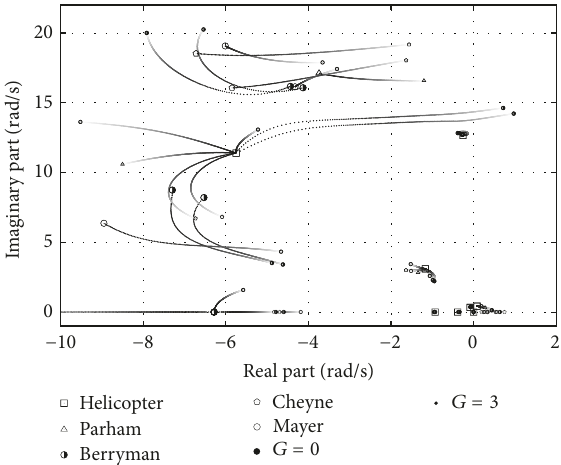
Figure 11: Lateral pilot-in-the-loop root loci, for gearing ratio